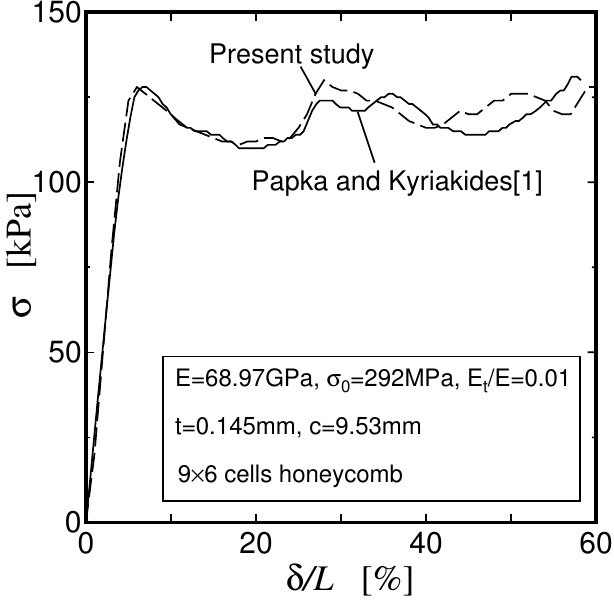
Figure 1. Comparison of stress-strain responses for a honeycomb investigated by Papka and Kyriakides